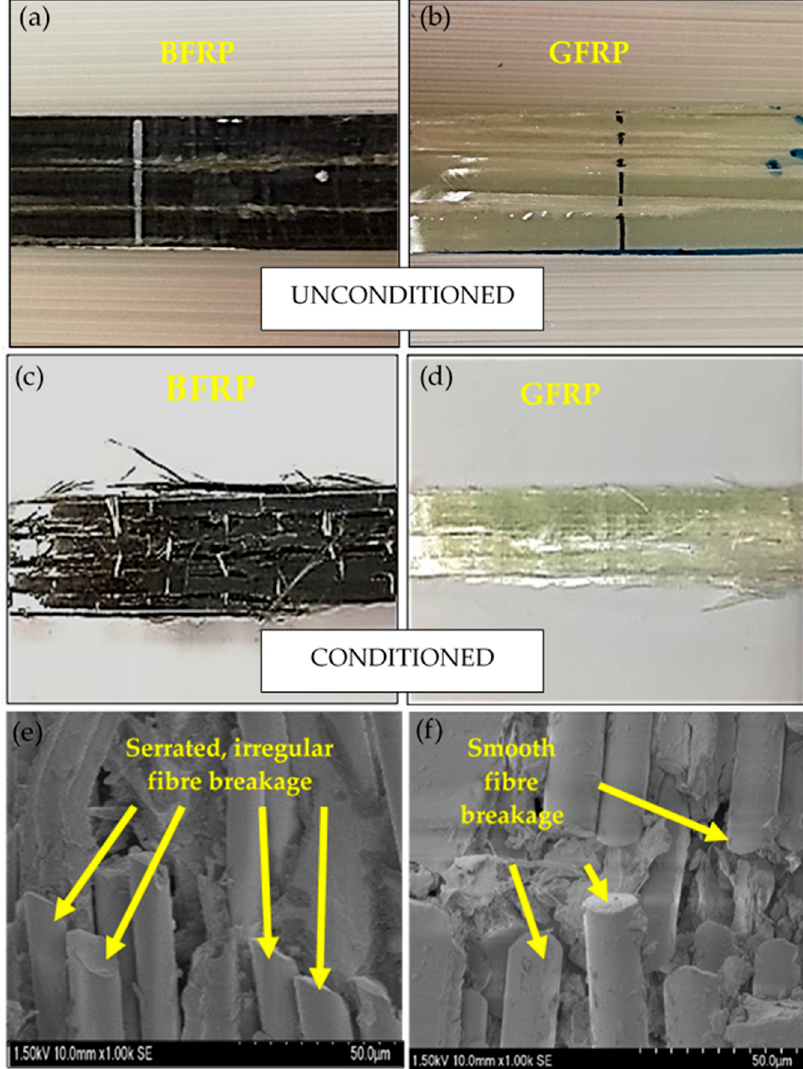
Figure 7. Fractured specimens of unmodified composites under tensile loading for ( a , b ) unconditioned, Figure 7 . Fractured specimens of unmodified composites under tensile loading for ( a ), ( b ) ( c , d ) conditioned and, ( e , f ) SEM micrographs of the damaged unconditioned, ( c ), ( d ) conditioned and, ( e ), ( f ) SEM micrographs of the damaged specimens.